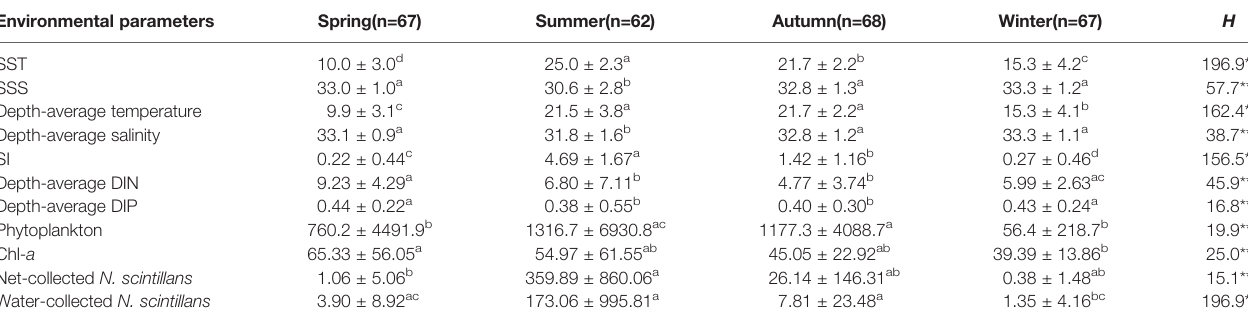
TABLE 1 | Comparison of depth-integrated abundance of N. scintillans and environmental variables (mean ± standard deviation) in the East China Sea and southern Yellow Sea in different seasons by using Kruskal – Wallis ( H ) test. Environmental